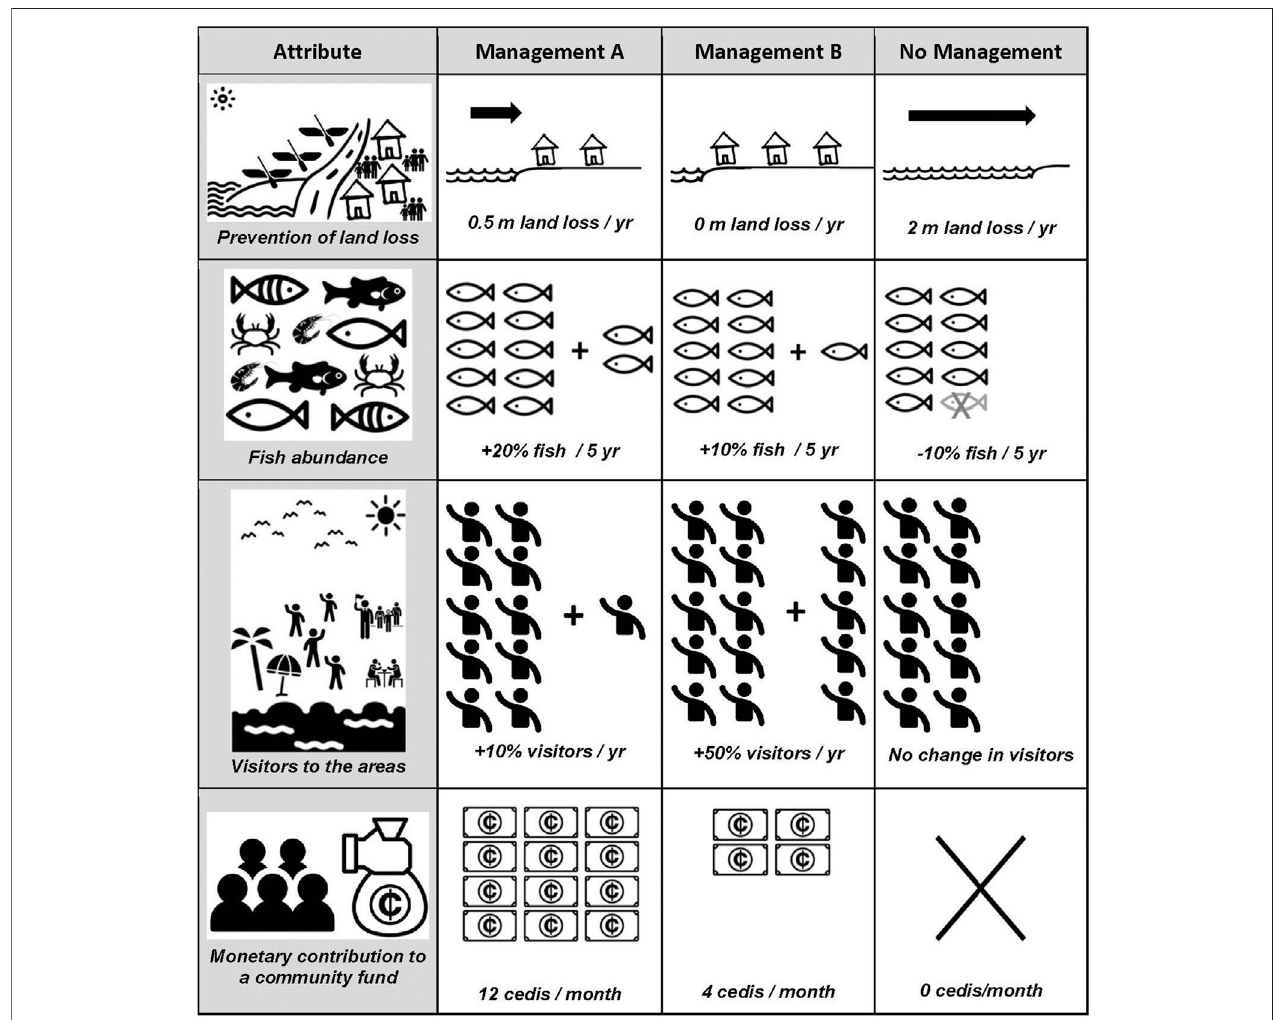
FIGURE 3 | Example choice card for the money payment vehicle, used in both the rural and urban study site.